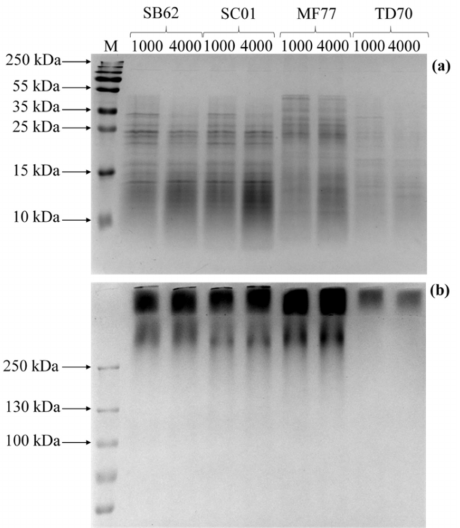
Figure 6. SDS-PAGE visualization of proteins and carbohydrates obtained from samples of SB62, SC01, MF77 and TD70 after ultrasound treatment and incubation with 1000 U or 4000 U lyticase per g dry cells weight, for 20 h. ( a ) Visualization of proteins after Coomassie staining. ( b ) Visualization of carbohydrates after PAS staining.